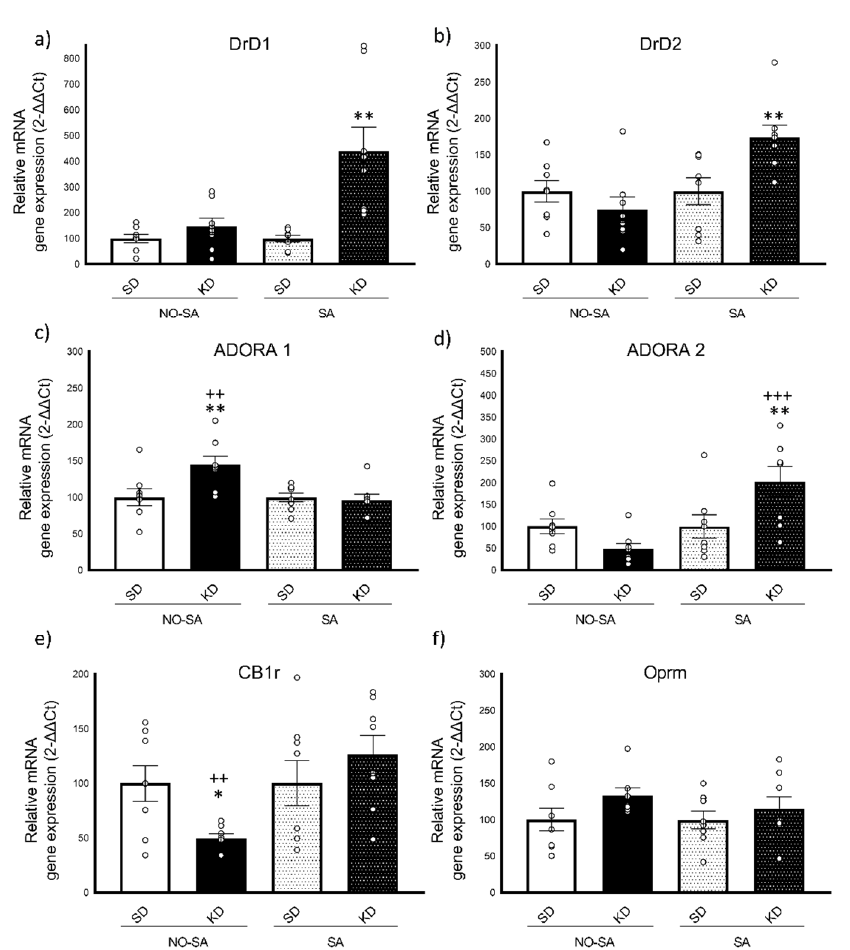
Figure 5. Real-time PCR Gene expression in the striatum ( n = 8/condition). ( a ) Dopamine receptor D1 gene―DrD1, ( b ) Dopamine receptor D2 gene―DrD2, ( c ) Adenosin receptor A1 gene―ADORA1, ( d ) Adenosin receptor A2 gene―ADORA2, ( e ) Cannabinoid receptor 1―CB1r, ( f ) Opioid receptor μ―Oprm. The columns represent means and the vertical lines ± SEM of relative (2-ΔΔCt method) gene expression in the striatum of OF1 mice. * p < 0.05; ** p < 0.01 significant differences with respect to the corresponding SD group. ++ p < 0.01; +++ p < 0.001 significant differences with respect to their corresponding KD group.